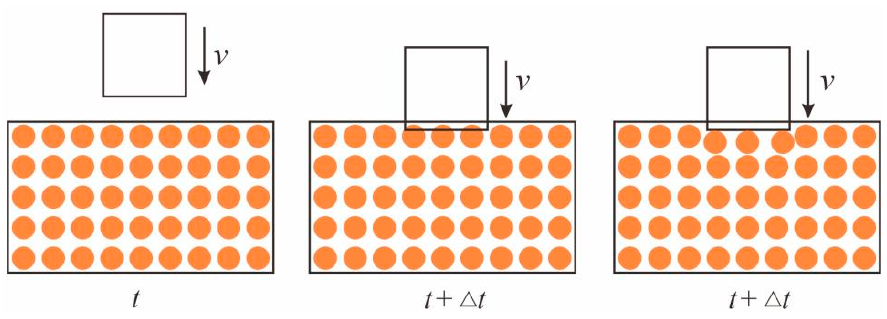
Figure 4. Rigid projectile impact contact model.